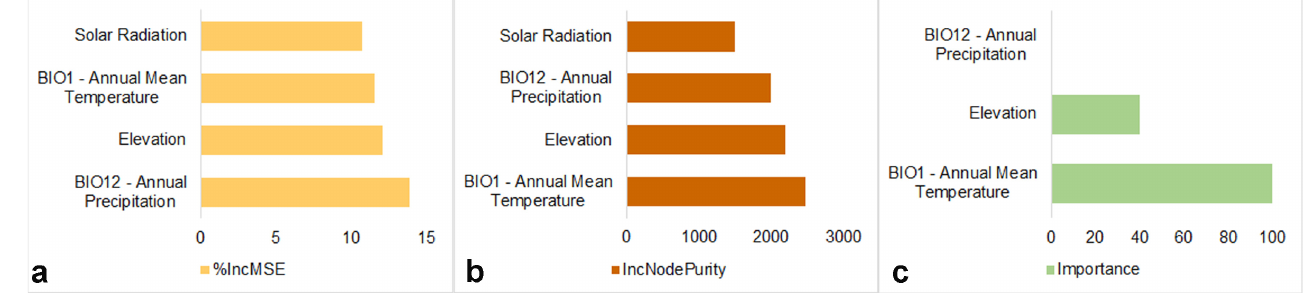
Figure 10. Variable importance for RF ( a , b ) and LR ( c ).